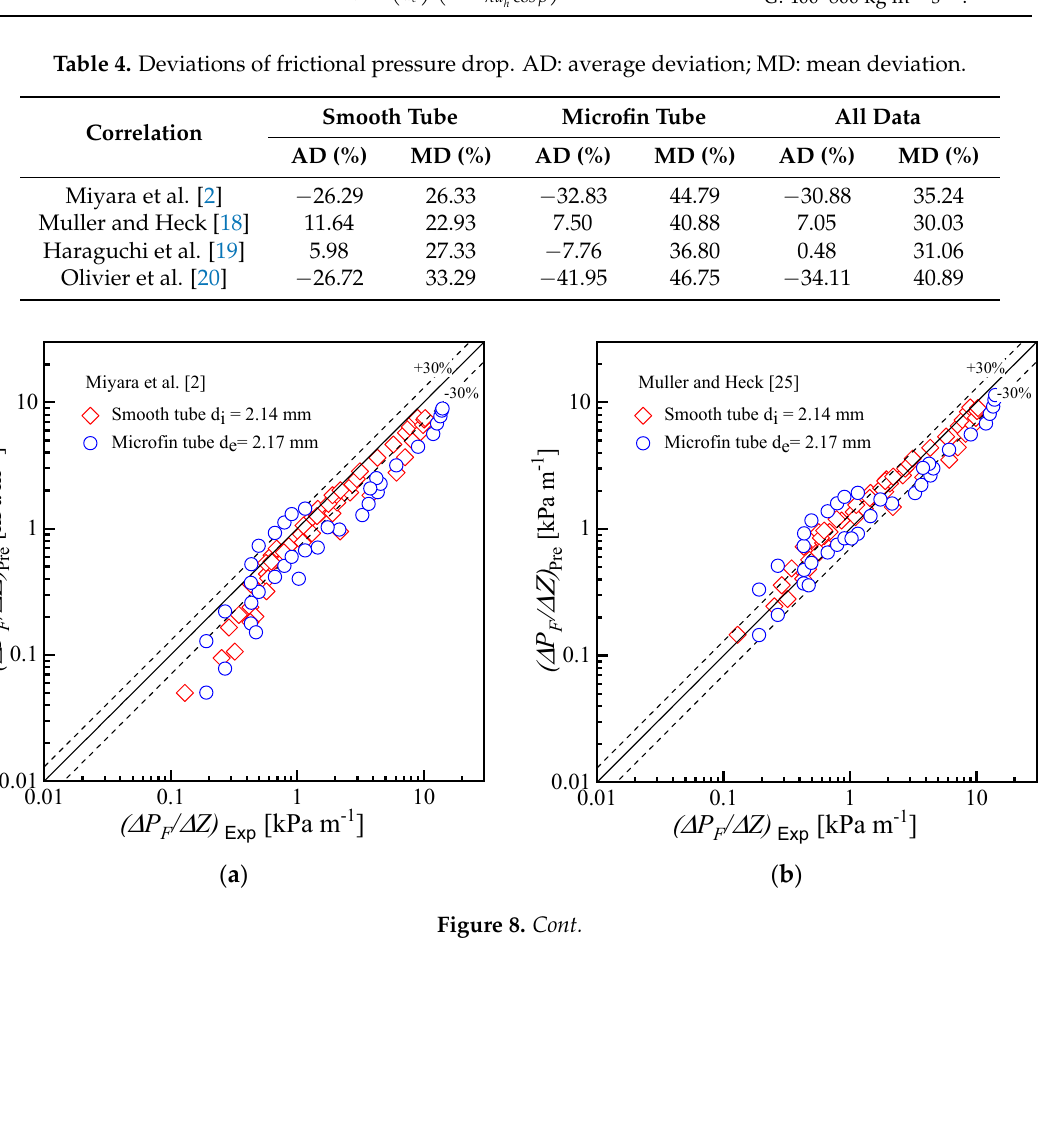
Table 3. Pressure drop correlations.